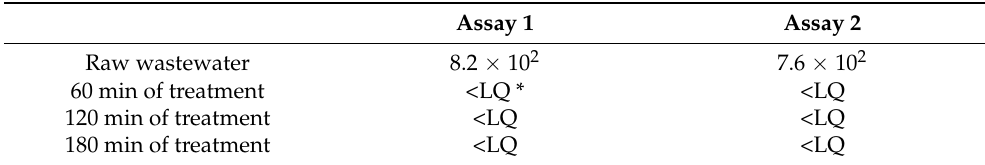
Table 3. Quantitative determination of Escherichia coli (CFU mL − 1 ) in raw wastewater and wastewater treated with chitosan pellets containing